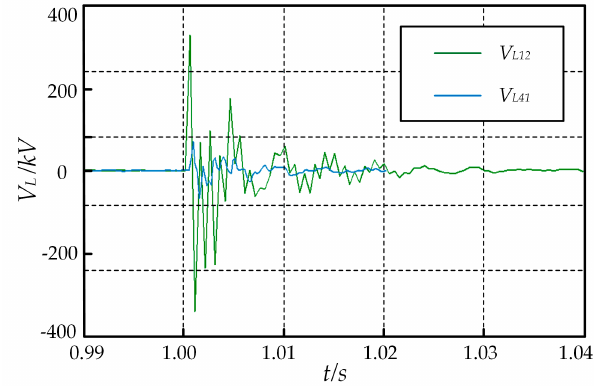
Figure 14. V L12 and V L41 when positive pole-to-ground fault.